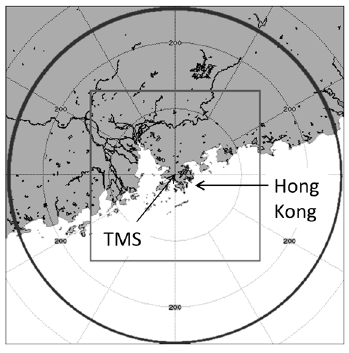
Figure 2. The circle depicts the 256 km range of a radar scan, while the inner gray square shows the product output domain. The crosshair denotes the location of Tai Mo Shan (TMS) radar.